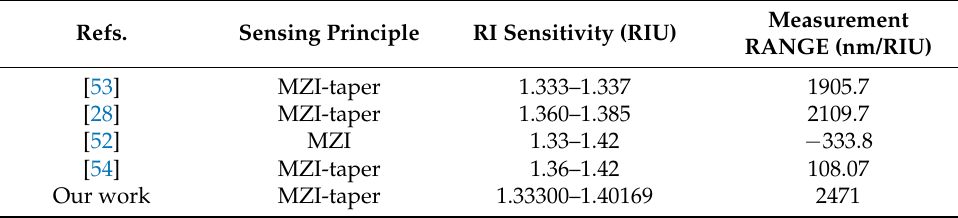
Table 3. Comparison with other published wavelength-modulated RI sensors. Refs.